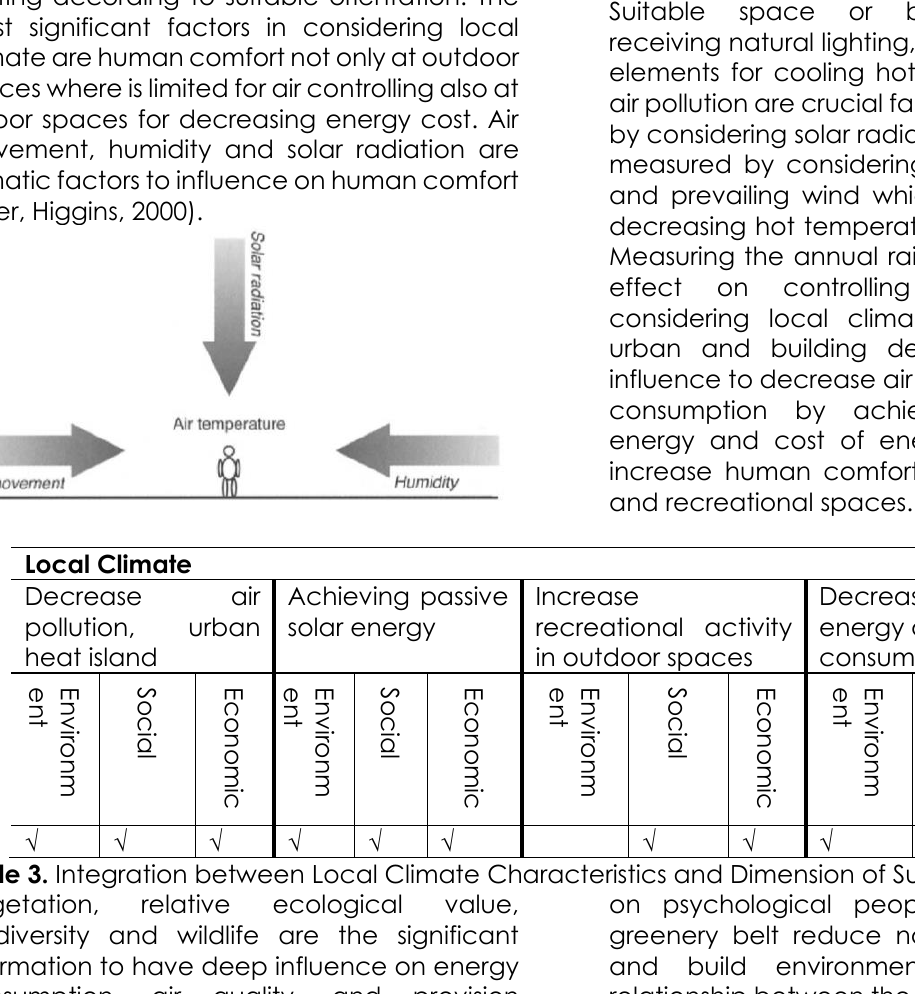
Figure 3. Climate Factors and Human Comfort (Beer, Higgins, 2000)